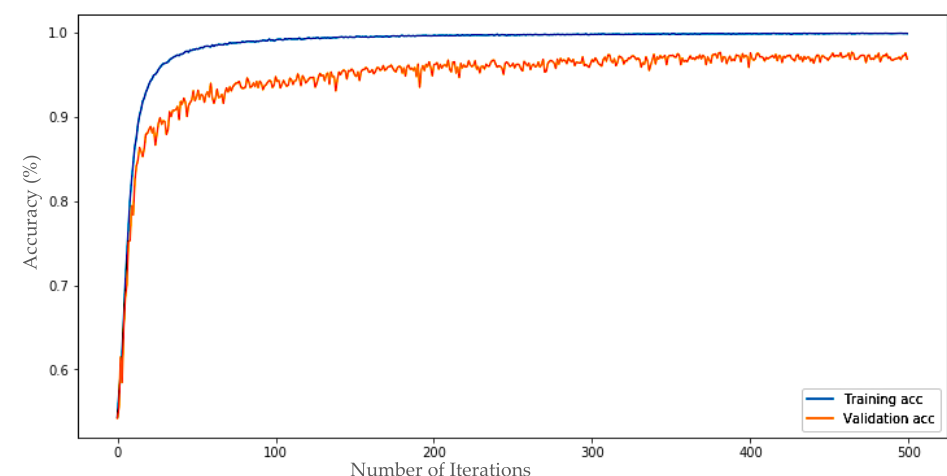
Figure 7. The proposed network error for two-class scenarios for F3 and C3 channels.